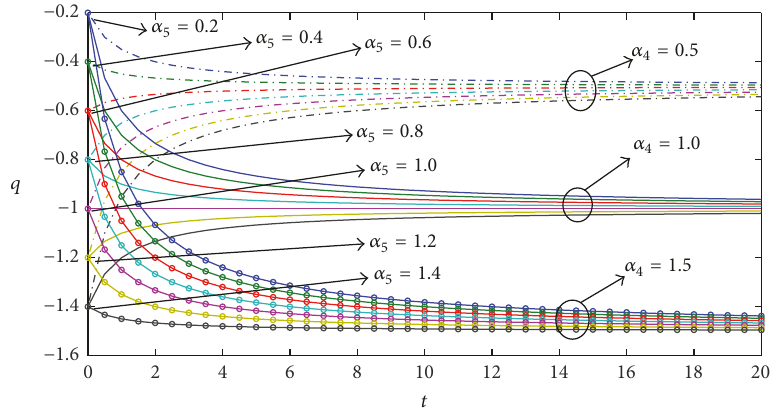
Figure 10: Variation of deceleration parameter against time for fixed 𝛼 4 and different 𝛼 5 .